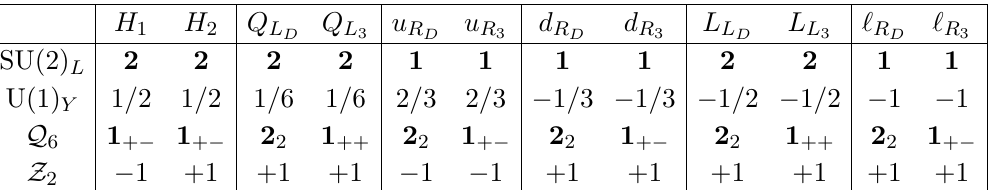
T , u ≡ ( u R D R 1 , u R 2 )